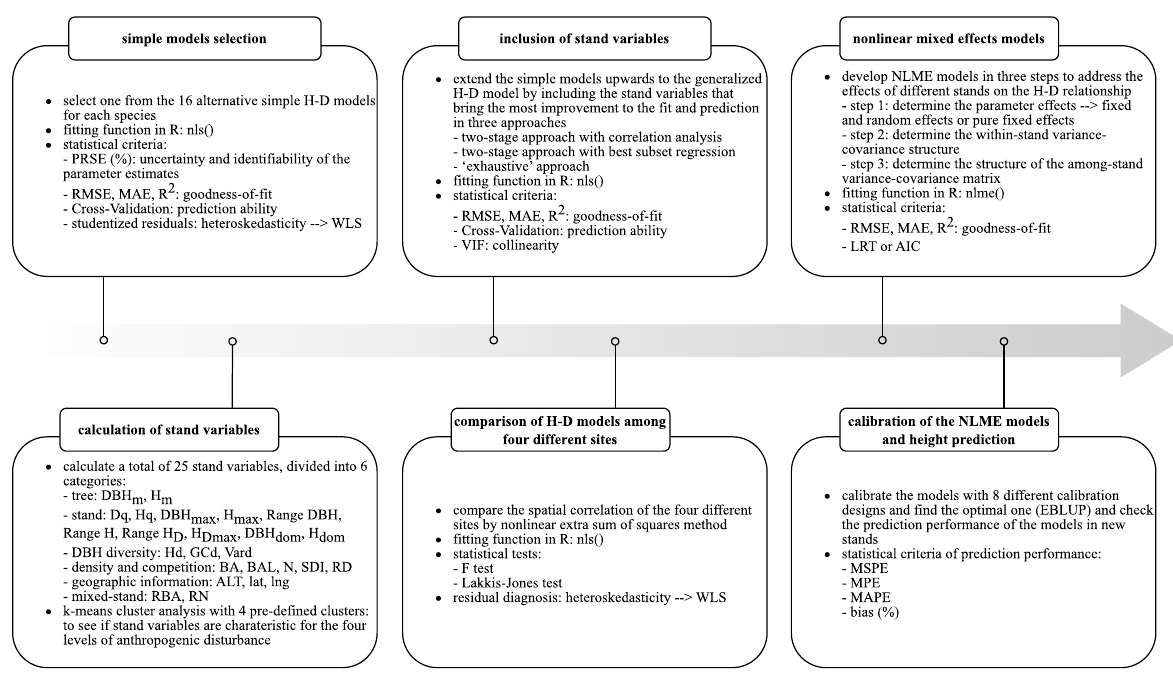
Fig. 3 Workflow for height-diameter model development and calibration. A detailed description of the approaches and techniques applied during each step of the workflow is provided in the appendix. See Table 12 for a list of simple models (SM1–SM16) tested